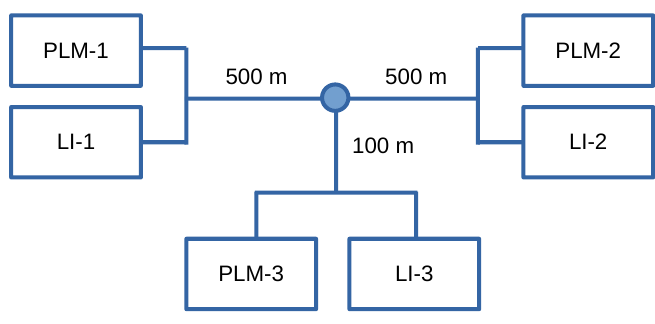
Figure 1. PLC network topology for synthetic data